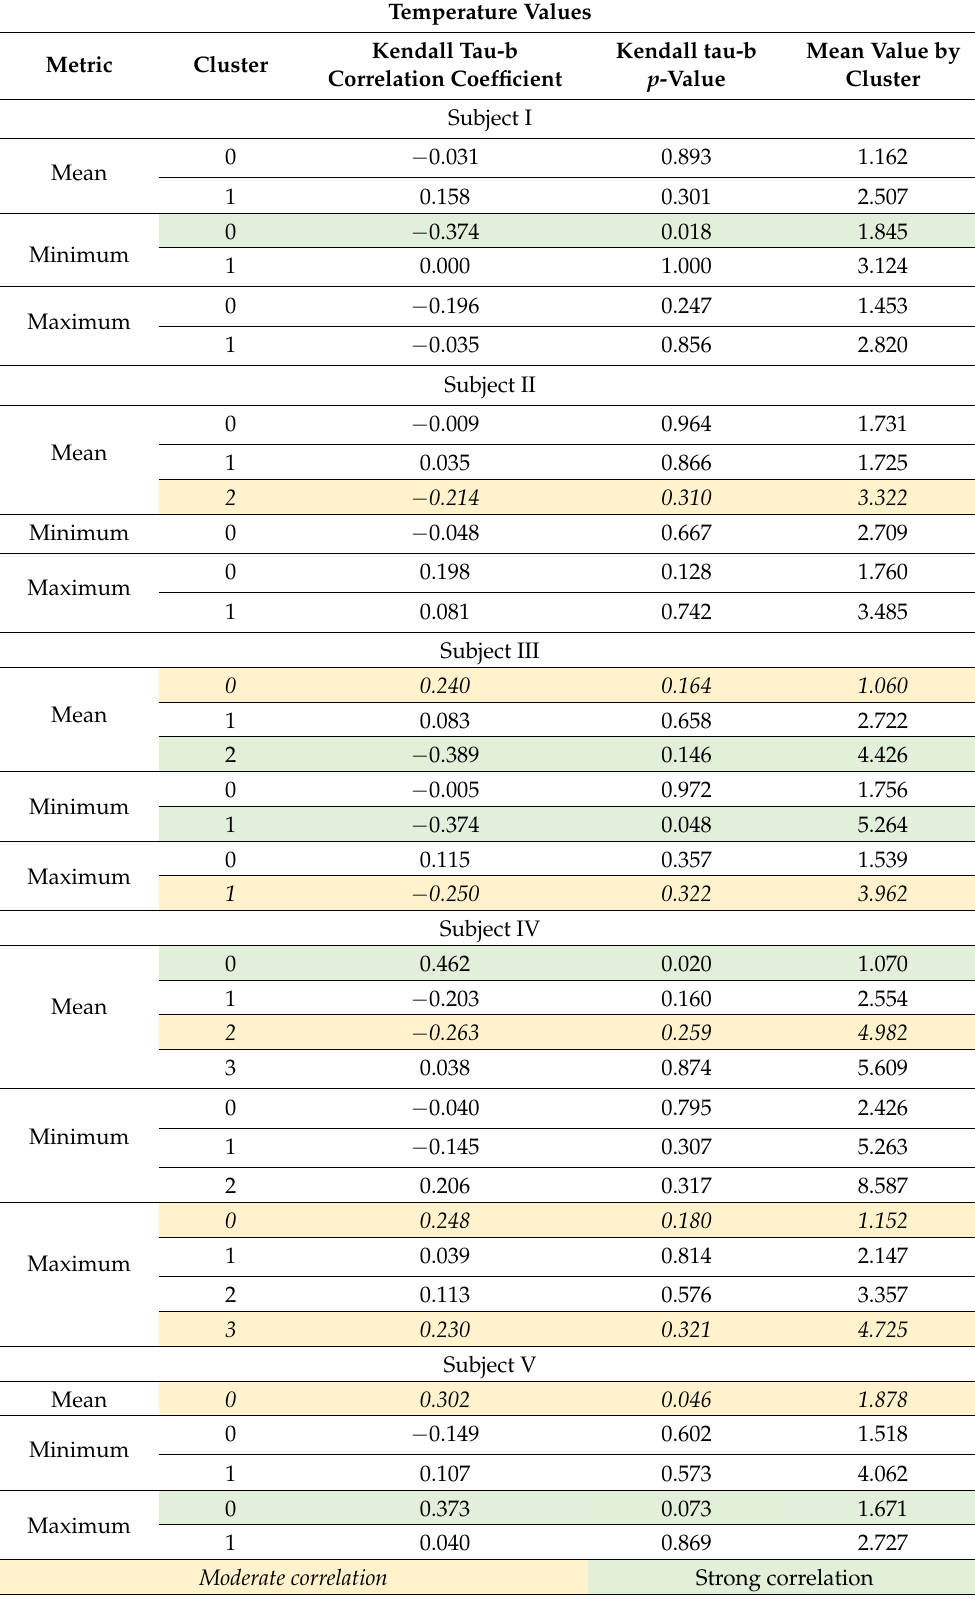
Table 4. Kendall tau-b statistical calculations of temperature by subject and